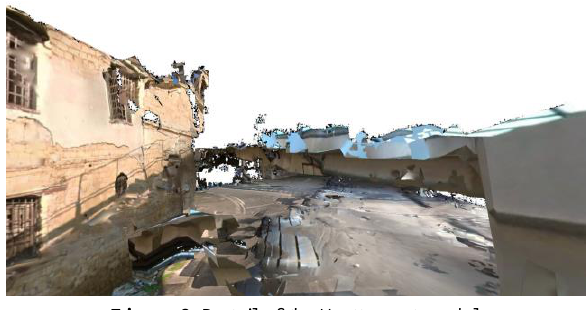
Figure 8 . Detail of the Matterport